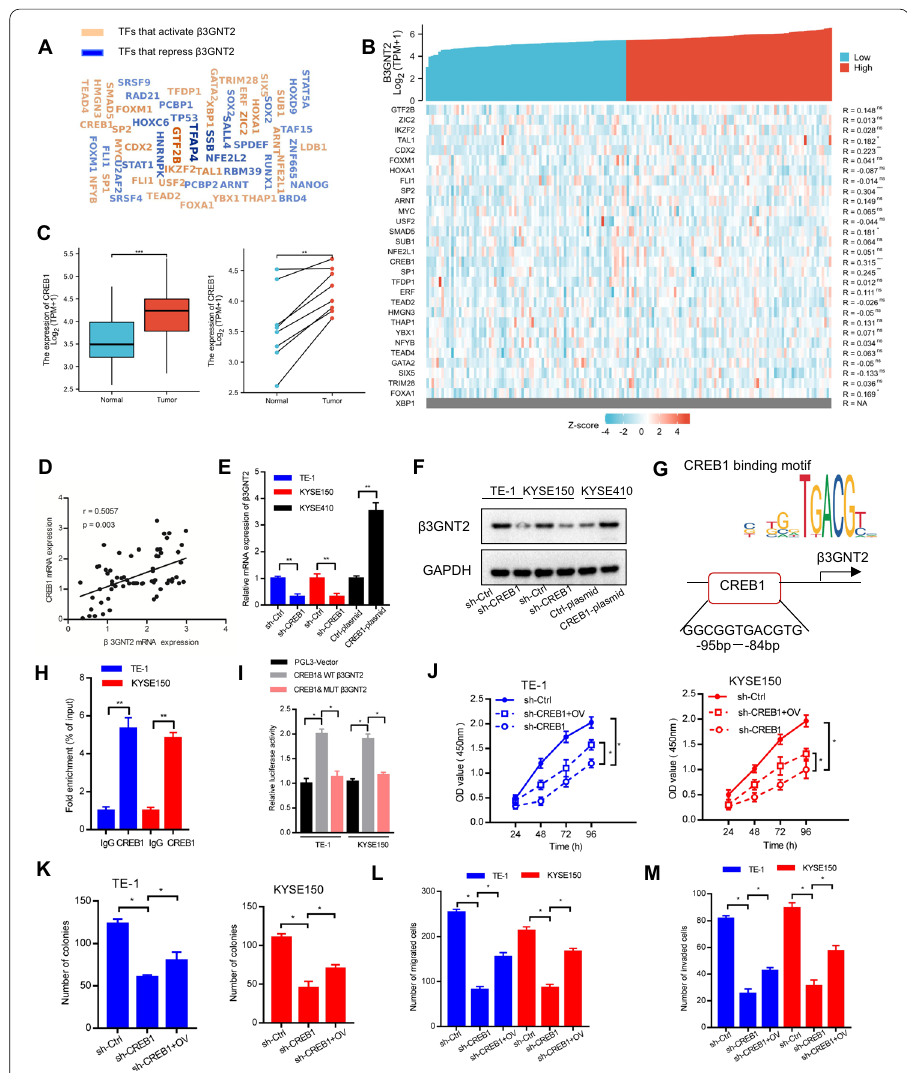
Fig. 7 β3GNT2 is a downstream target of CREB1. A Transcription factors (TFs) of β3GNT2 predicted by KnockTF. B Correlation analysis between transcriptional activators and β3GNT2 based on the TCGA and GTEx databases. C Analysis of β3GNT2 expression through the TCGA and GTEx databases. D Correlation analysis of CREB1 mRNA expression and β3GNT2 mRNA expression in clinical ESCA samples. E Analysis of β3GNT2 mRNA expression by qPCR. F Analysis of β3GNT2 protein expression by Western blot. G CREB1 binding site in the β3GNT2 promoter region. H ChIP-qPCR analysis of CREB1 binding to the β3GNT2 promoter. I Dual-luciferase reporter activity assay. J – M The proliferation, colony formation, migration, and invasion of cells co-transfected with β3GNT2 overexpression plasmid and CREB1 shRNA were measured by CCK-8 assay ( J ), colony formation assay ( K ), Transwell migration assay ( L ), and Matrigel invasion assay ( M ). Cells were transfected with the indicated plasmids. WT, wild-type; MUT, mutant; OV, pcDNA3.1/β3GNT2 plasmid; sh-Ctrl, control shRNA; sh-CREB1, CREB1 shRNA lentiviral vector. Data are expressed as mean SD. NA, Data not available; *P < 0.05; ± **P < 0.01; ***P <